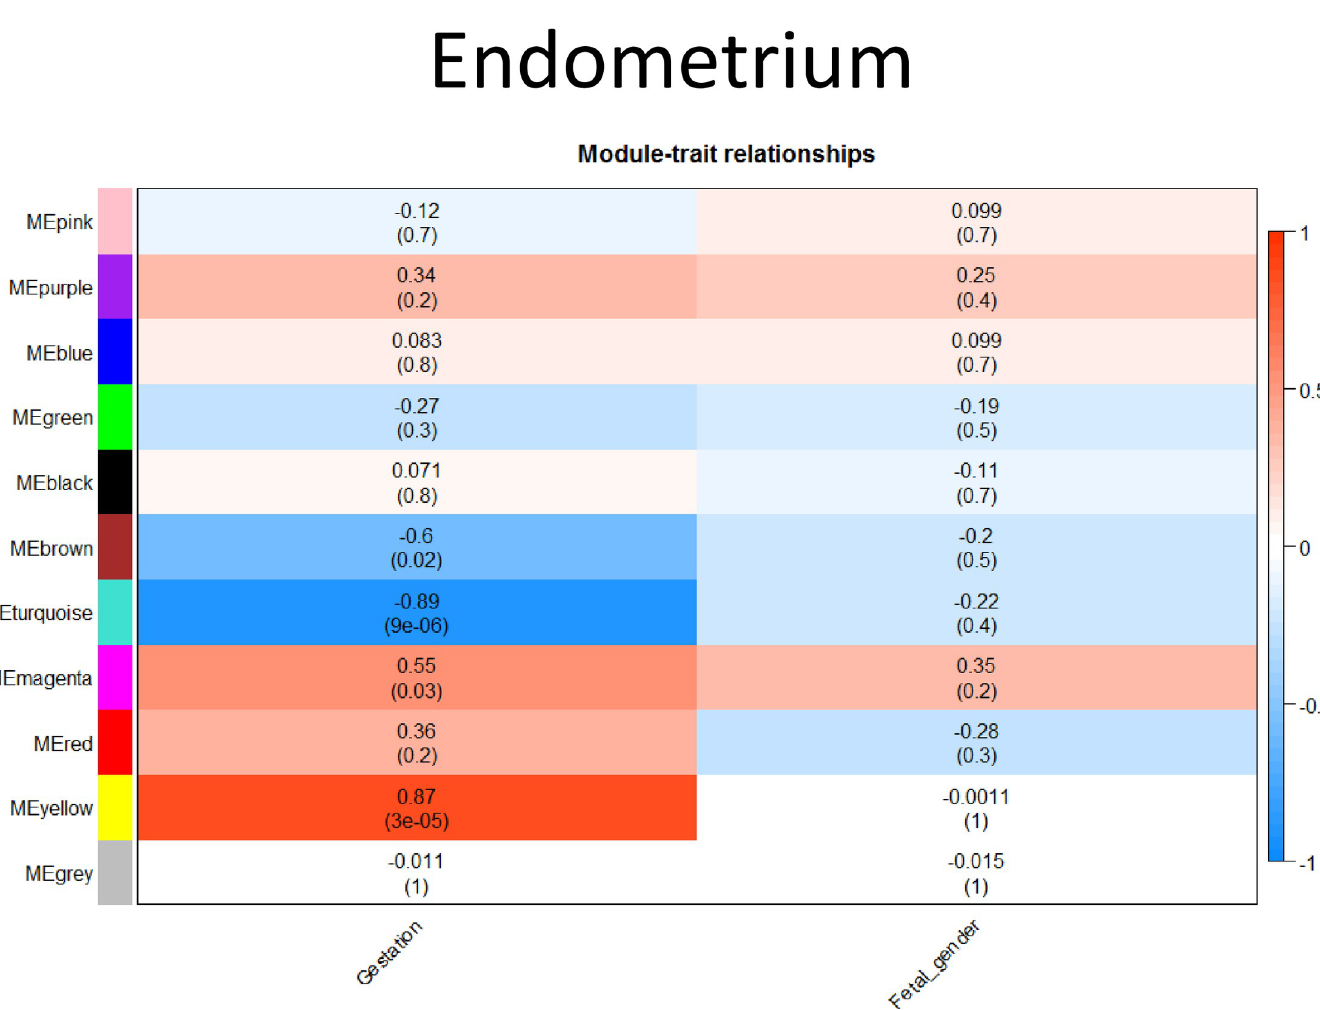
Fig 8. Weighted Gene Co-Expression Network Analysis (WGCNA) in endometrium. Correlation (r) of each module identified by WGCNA to external factors (Gestation and fetal gender). Color and depth of color corresponds to depth of correlation, with positive correlation indicated in red, negative correlation indicated in blue. Significance (P-value) of each module to each external factor presented in parentheses